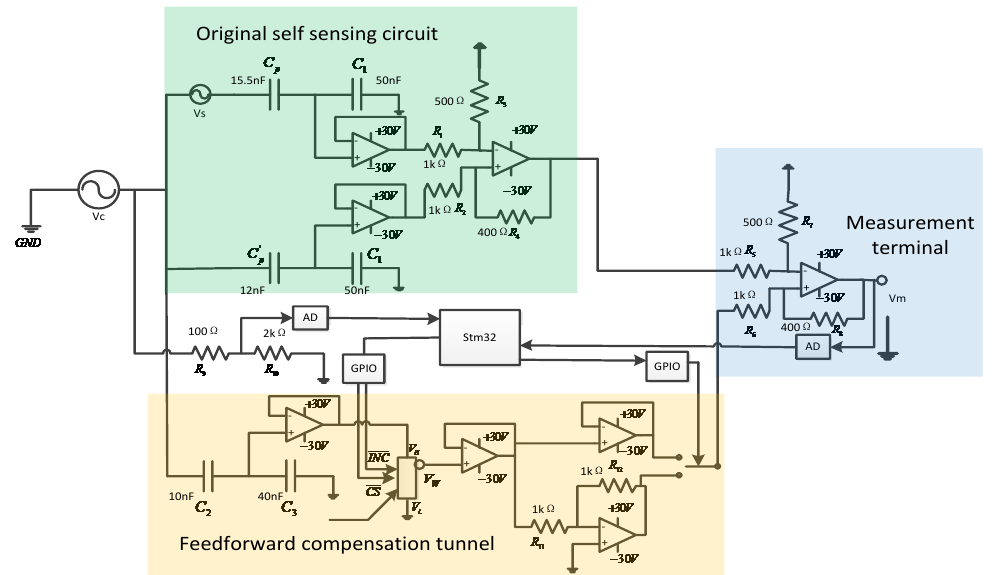
Figure 3. Improved self-sensing piezoelectric actuation circuit.